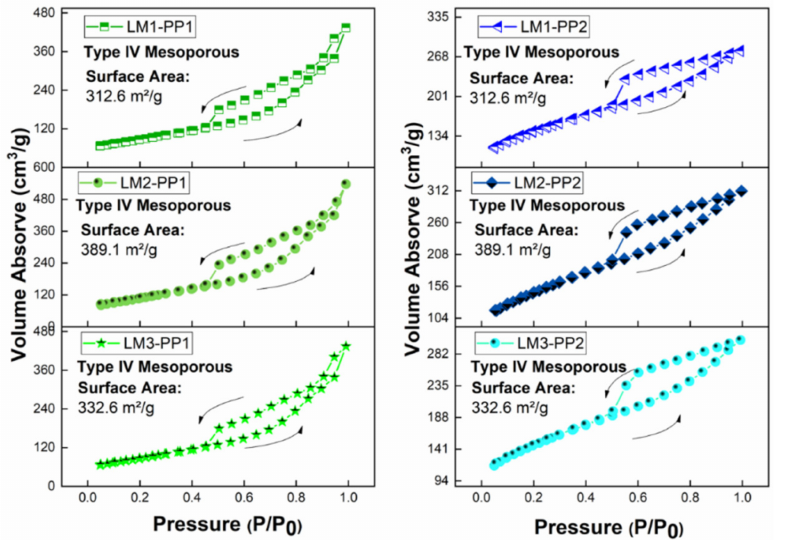
Figure 9. BET N 2 adsorption-desorption isotherms and hysteresis loop: ( left ) PP1 and ( right ) PP2 samples.